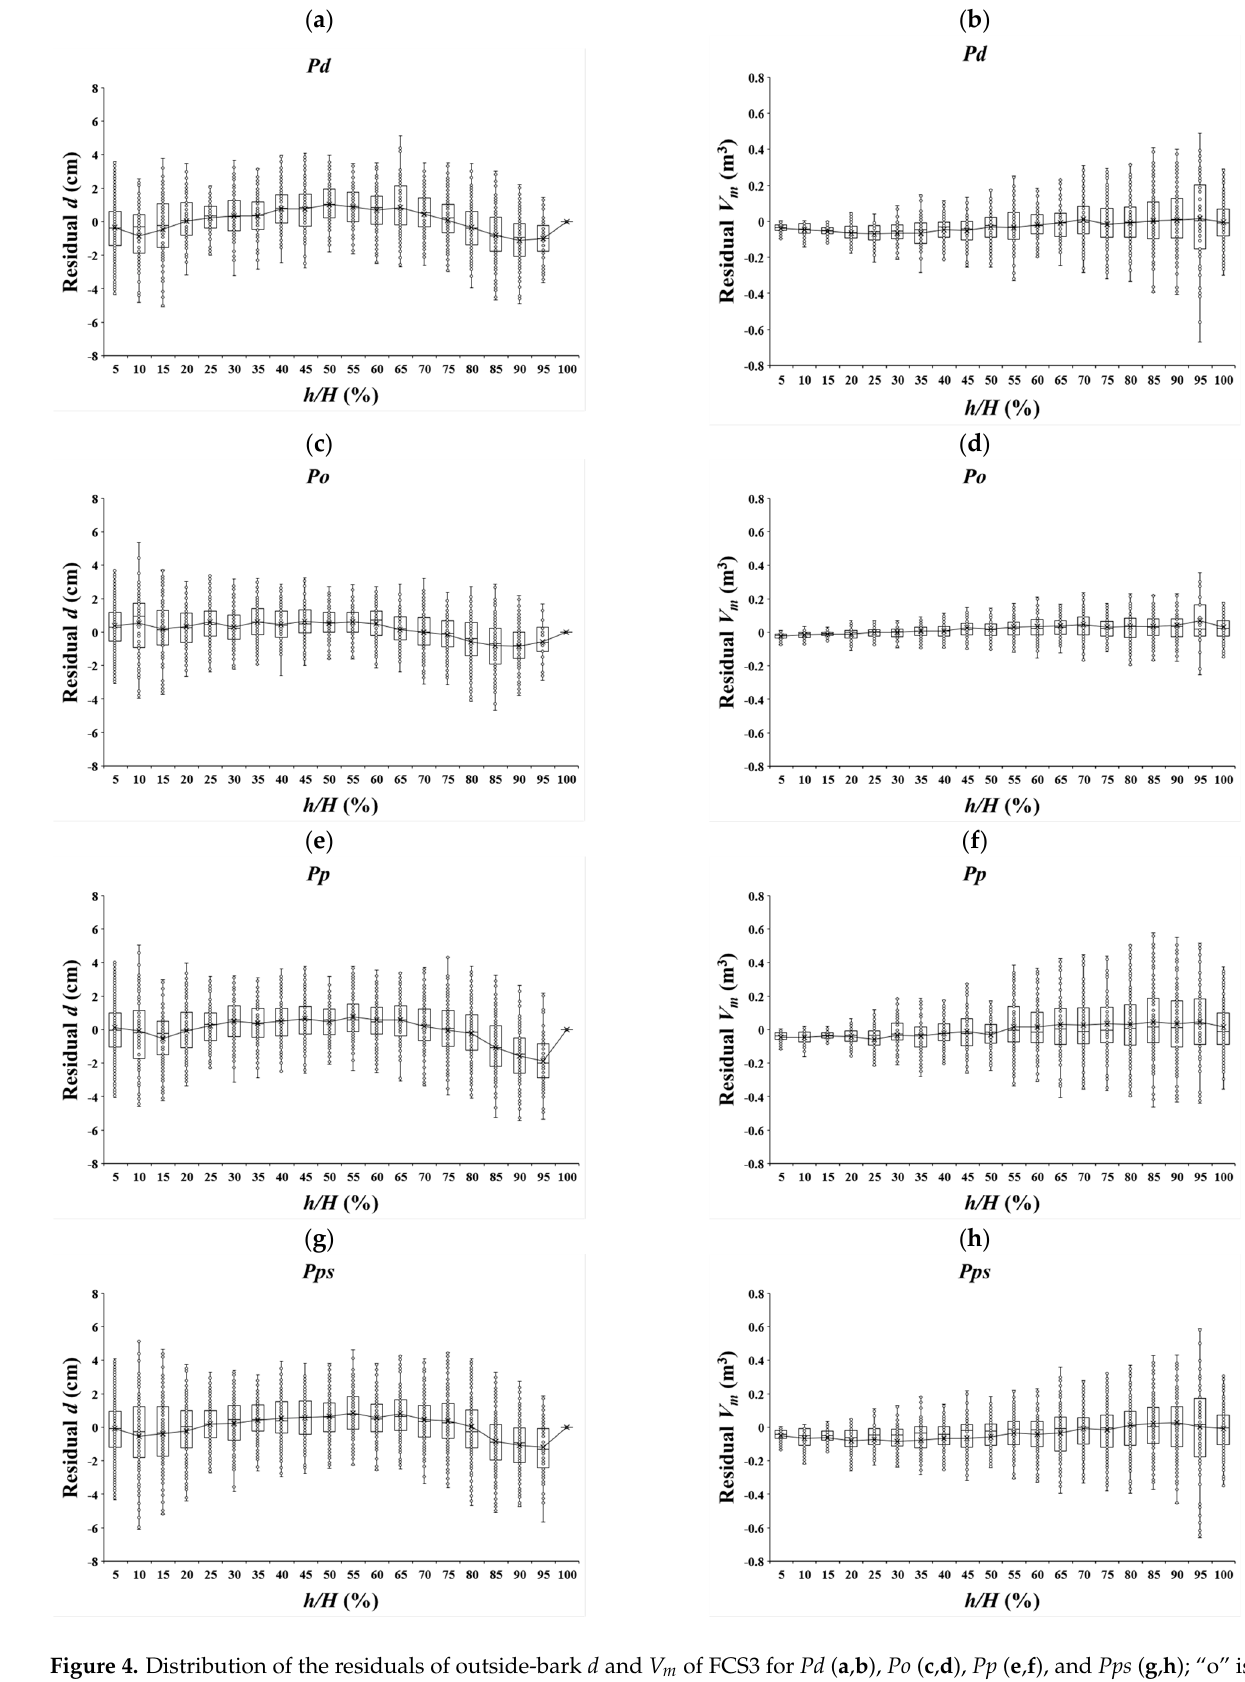
Figure 4. Distribution of the residuals of outside-bark d and V m of FCS3 for Pd ( a , b ), Po ( c , d ), Pp ( e , f ), and Pps ( g , h ); “o” is the mean, “-” the median of the residuals, and “I” the error bar representing the interquartile range